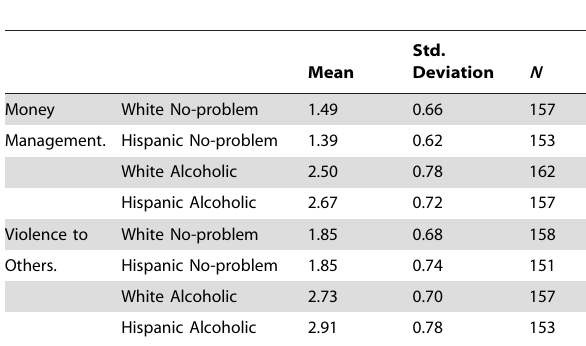
Table 3. Summary Statistics for Stereotype-Consistent Norms.